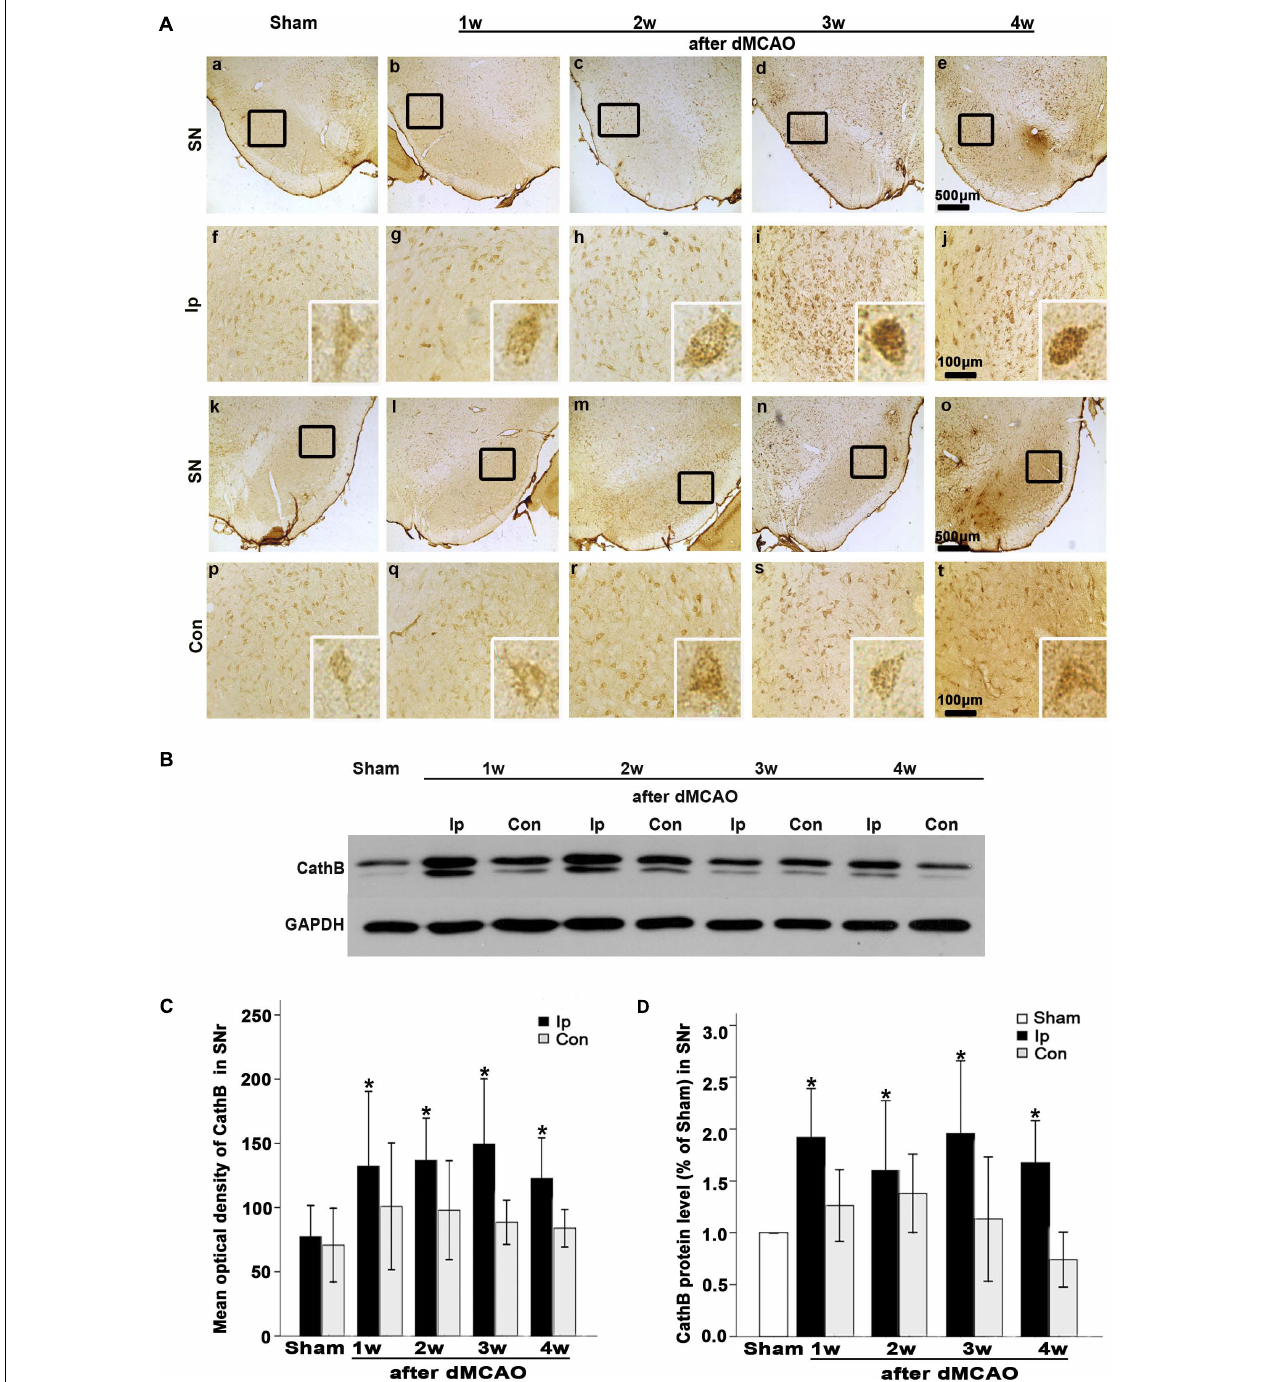
FIGURE 4 | CathB was upregulated in the ipsilateral SNr after dMCAO. (A) Representative microphotographs of immunohistochemistry of CathB in the ipsilateral SNr at 1–4 weeks after dMCAO or sham operation: a , f , k , p , sham-operated; b–e , g–j , ipsilateral SNr after dMCAO; l–o , q–t , contralateral SNr after dMCAO. Scale bar: a–e : 500 µ m; f–o : 100 µ m. (B) Western blot analysis of CathB protein in the SN after dMCAO. (C) Quantitative analysis of CathB positive density in the SNr at 1–4 weeks after dMCAO ( n = 7, 7, 6, and 7, respectively) and sham-opreated groups ( n = 6). Data are expressed as percentage of value of sham-operated animals. Each bar represents the mean ± SD. ∗ p < 0.05 versus the sham-operated animals. (D) Quantitative analysis of CathB protein in the SNr after normalization by GAPDH protein of the same sample. Data are expressed as percentage of value of sham-operated animals. Each bar represents the mean ± SD ( n = 5 in each group). ∗ p < 0.05 versus the sham-operated animals. GAPDH, glyceraldehyde 3-phosphate dehydrogenase; Ip, ipsilateral; Con, contralateral; Sham, sham-operated; w, week.